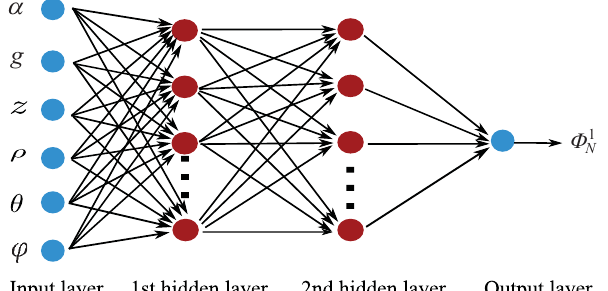
Fig. 18 Network structure of Ge et al. [65]. Reproduced with permission from Ref. [65], c (cid:2) IEEE 2019.